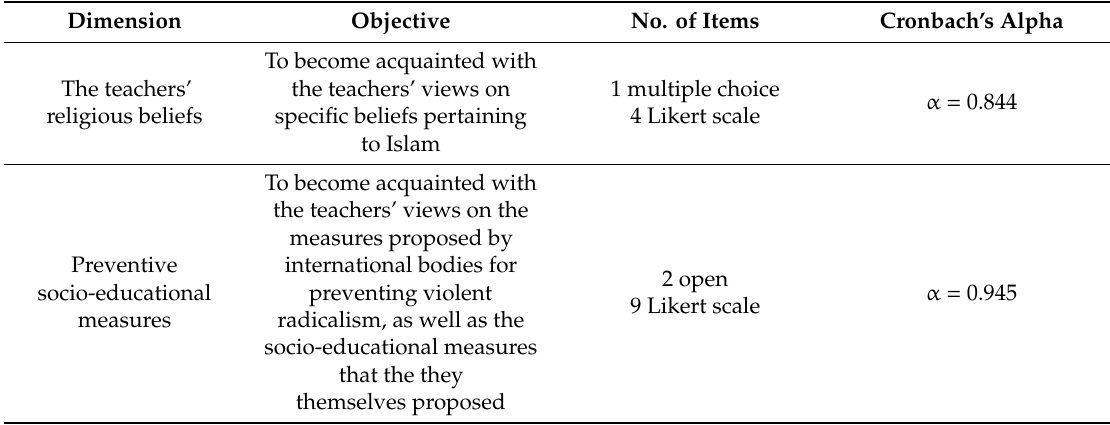
Table 1. Questionnaire dimensions